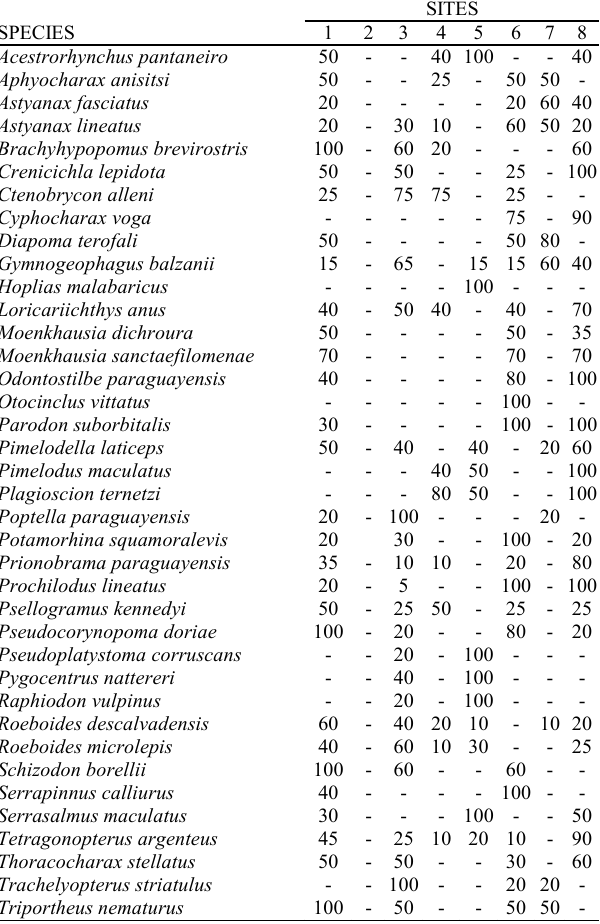
Table 4 Frequency of occurrence (%) of food resources exploited by the dominant fish in the Paraná River floodplain: 1-microcrustaceans; 2-molluscs; 3-insects; 4-others invertebrates; 5-fishes; 6-algae; 7-higher plants;